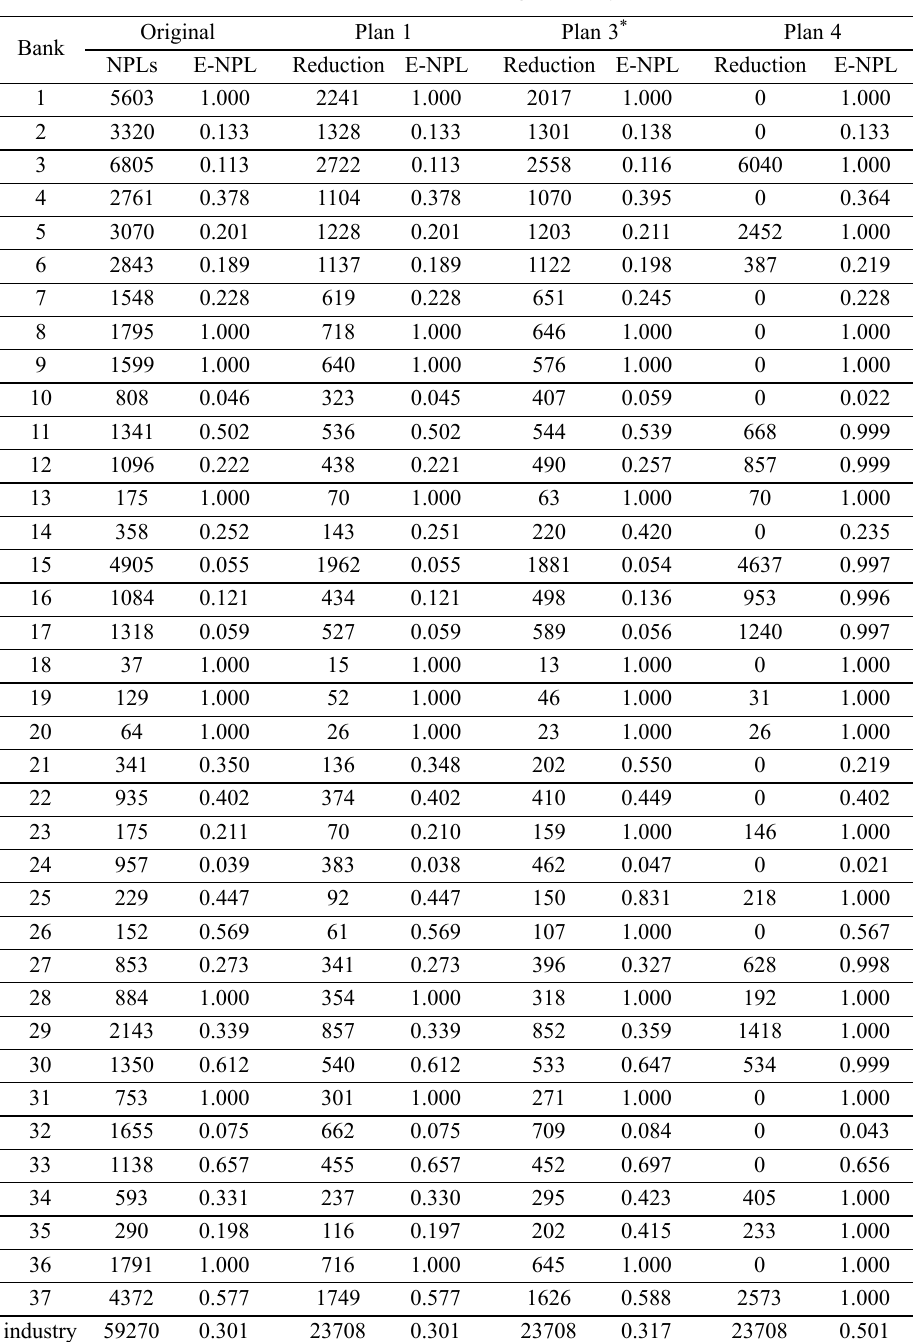
Table 3. Scenario of reducing NPLs by